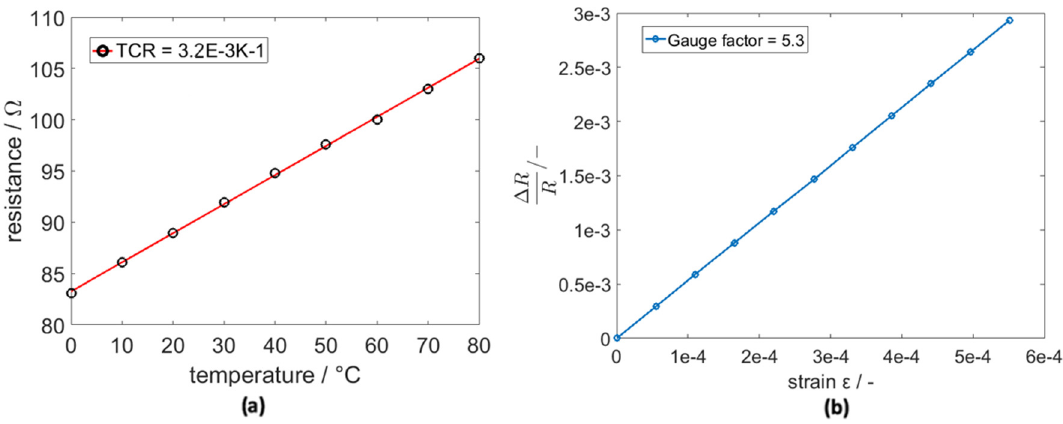
Figure 6. ( a ) The change in resistance with the temperature of the sensor; ( b ) the rate of resistance change due to the tensile strain of the sensor.